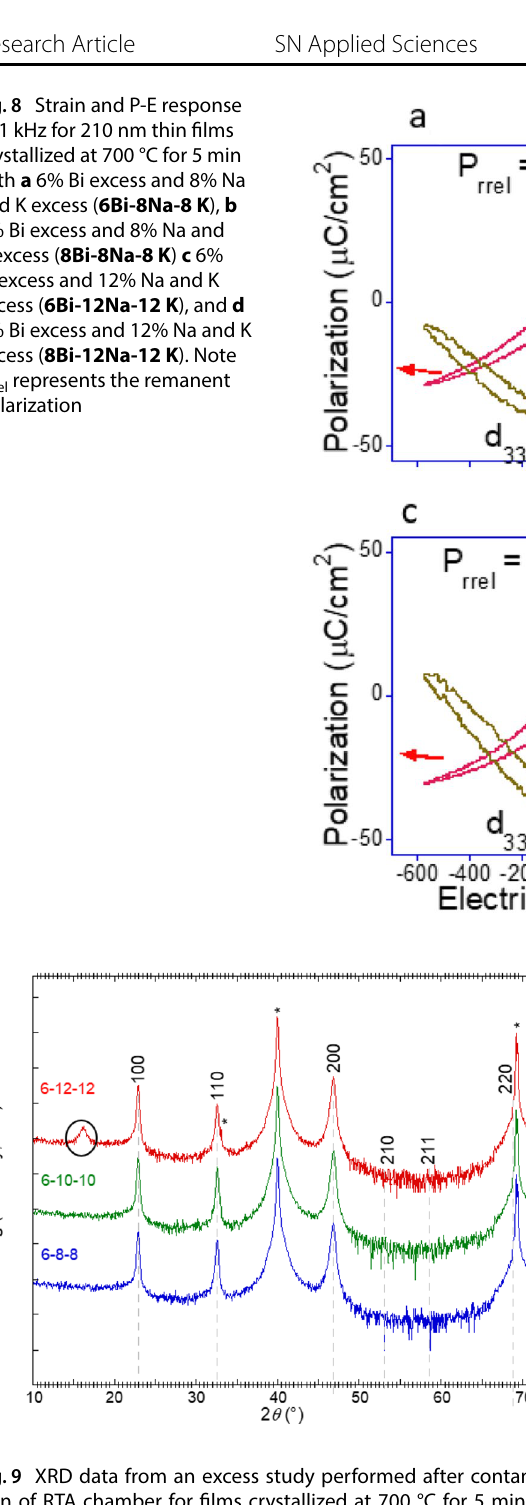
Fig. 9 XRD data from an excess study performed after contamina- tion of RTA chamber for films crystallized at 700 °C for 5 min with varying excess amounts: 6% Bi excess and 8% Na and K excess ( 6Bi- 8Na-8 K ), 6% Bi excess and 10% Na and K excess ( 6Bi-10Na-10 K ), and 6% Bi excess and 12% Na and K excess ( 6Bi-12Na-12 K ) with present BNKT peaks labeled (* was used to mark substrate